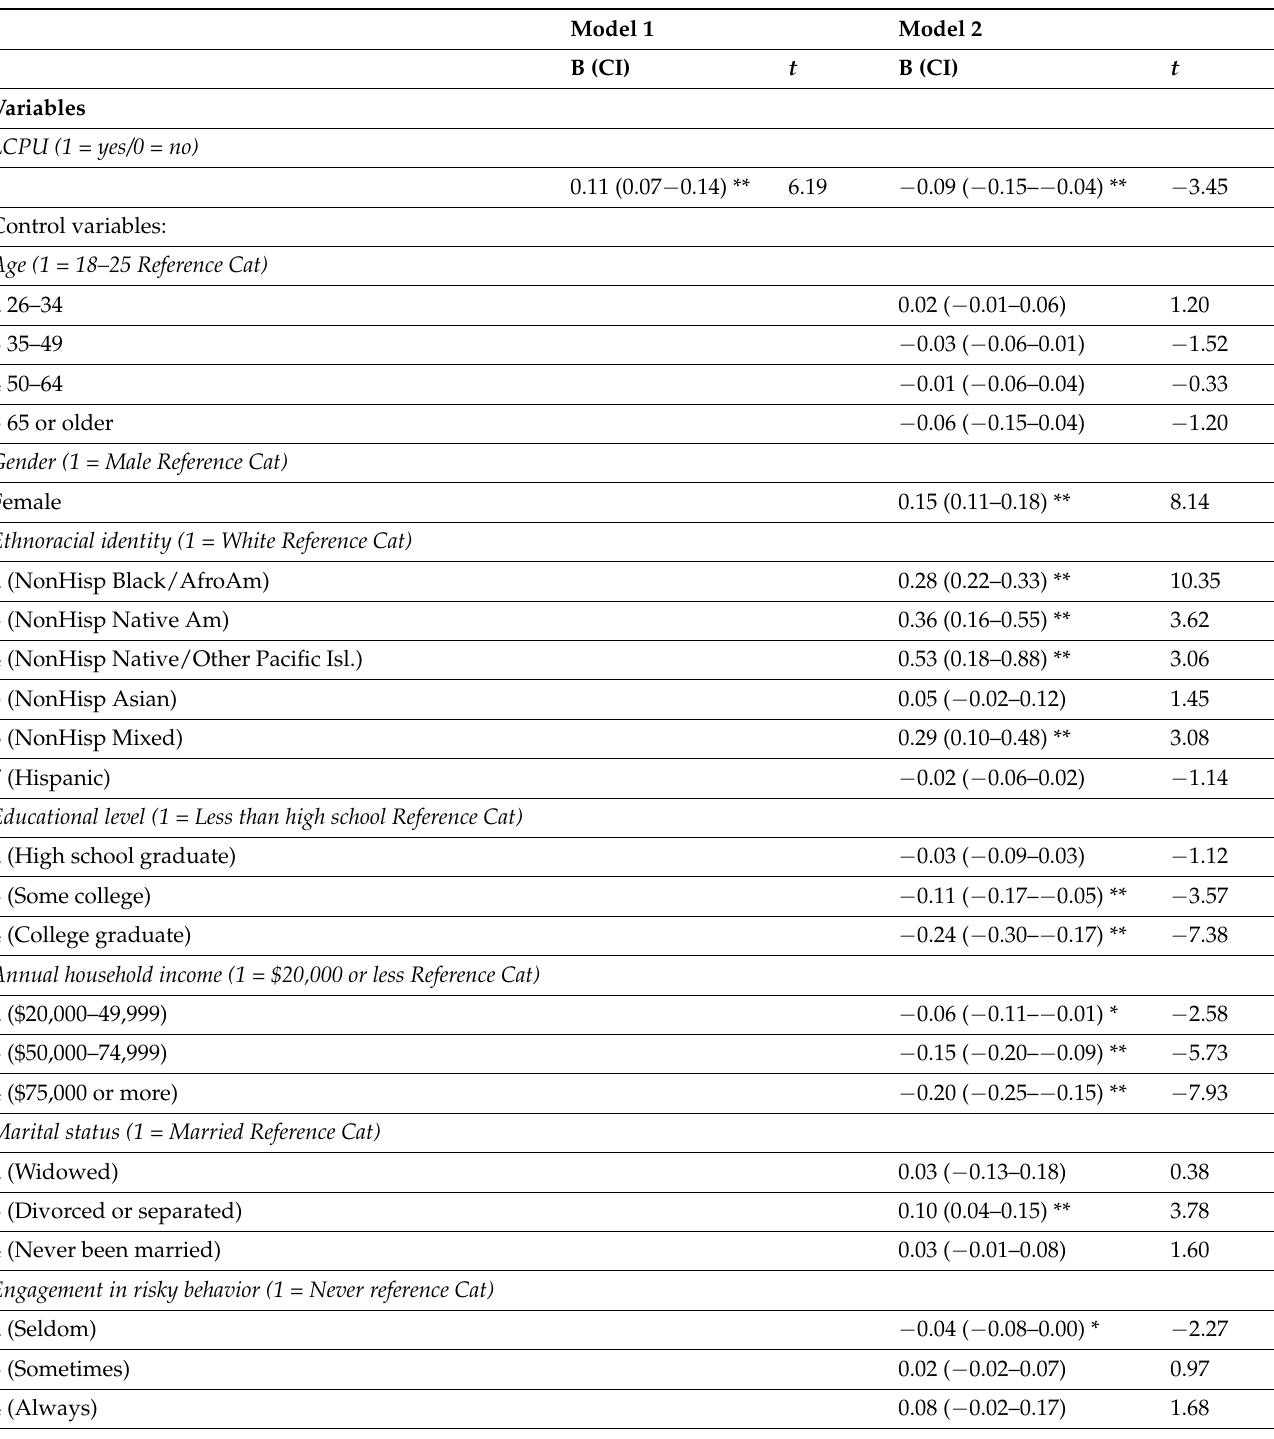
Table 1. Unstandardized regression coefficients (B), 95% confidence intervals (CI), and t -values ( t ), for lifetime classic psychedelic use (LCPU) on sick leave during the past 30 days (Model 1, N = 407,717; Model 2, N =